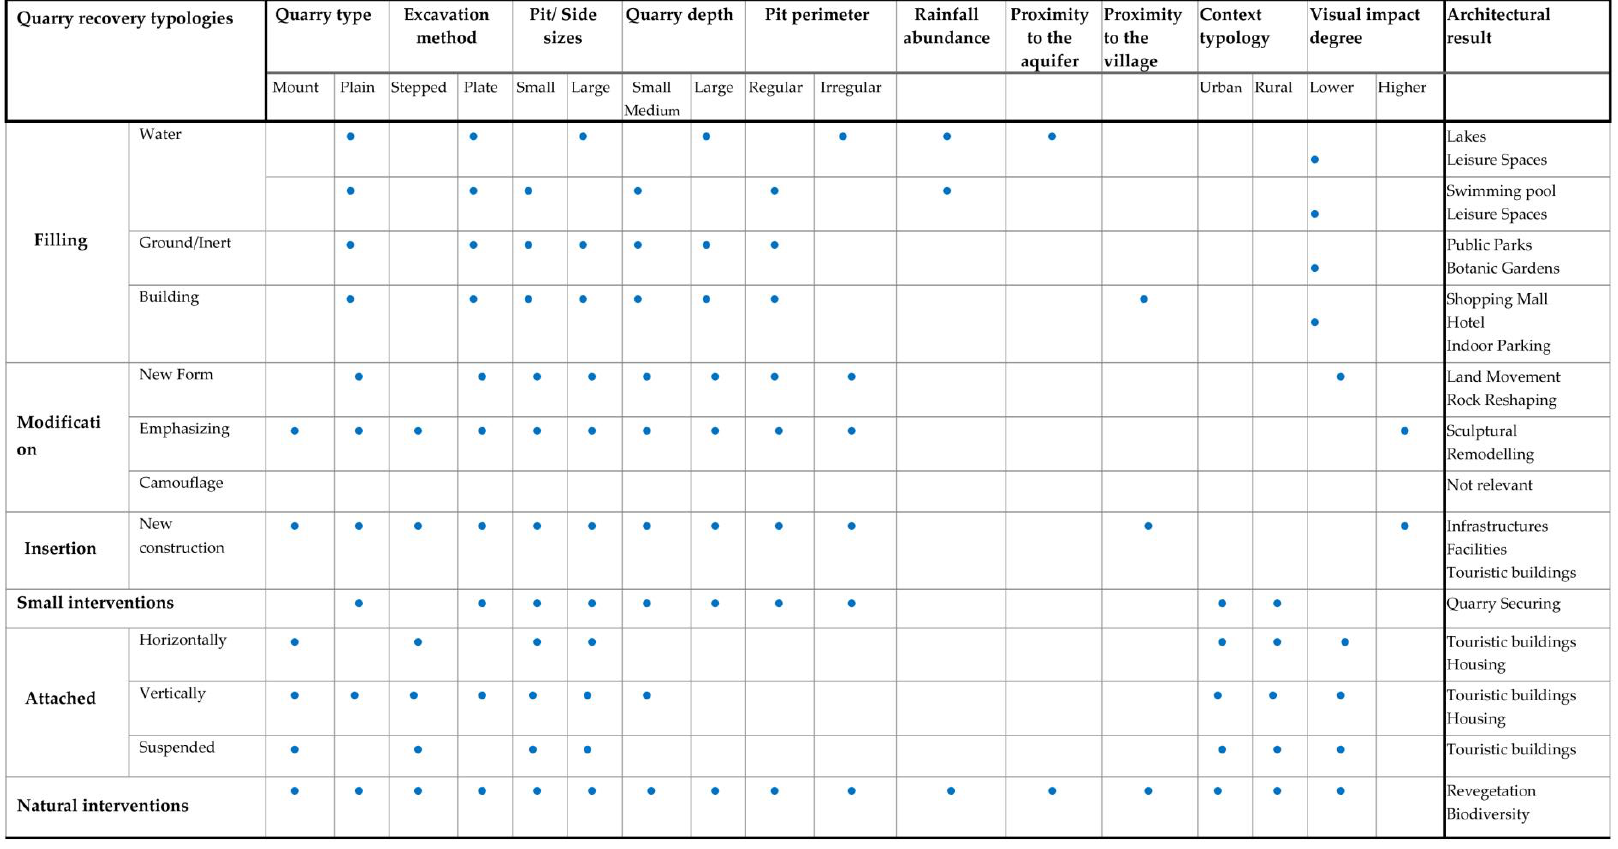
Figure 6. Scientific schematisation and discussion of quarry reconversion